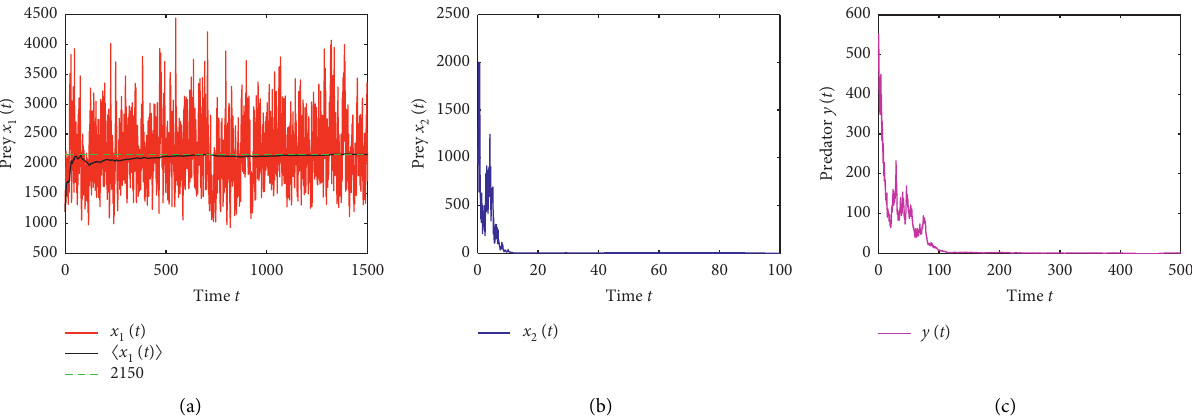
Figure 18: The trajectories of stochastic model (5) with σ 2 ( t ) , and (c) predator y ( t ) . x 2